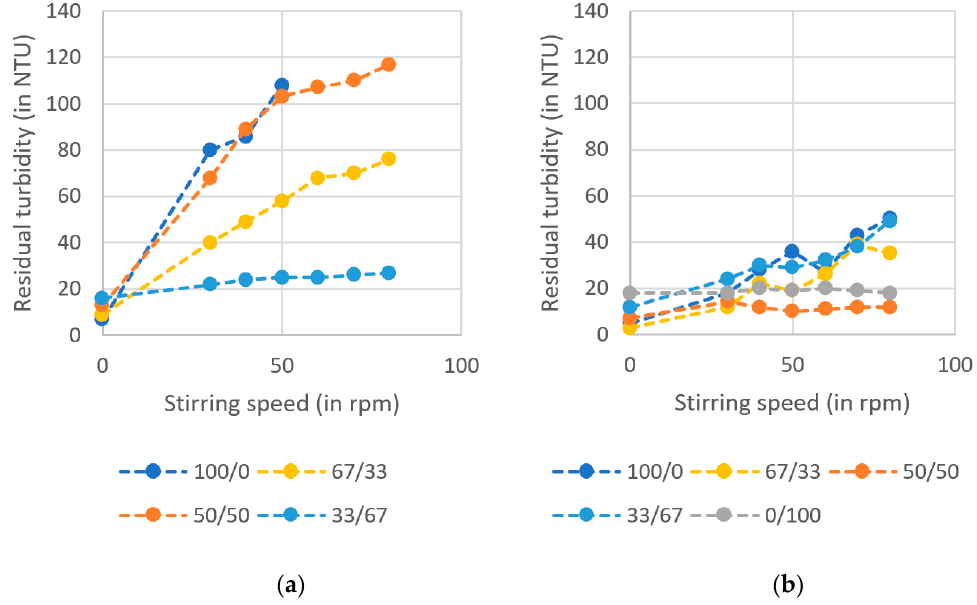
Figure 5. Shear strength of flocculants prepared with different mixing ratios of Moringa and cactus in model suspension ( a ) and surface water ( b ).